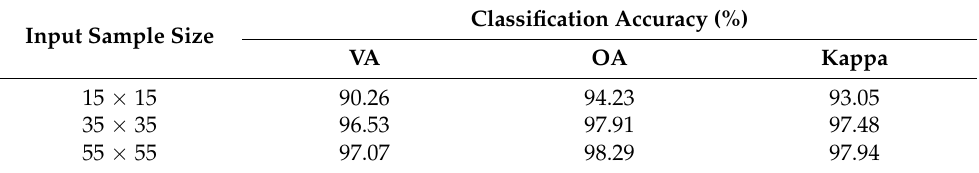
Table 8. The classification performance of CNN with different sample size.